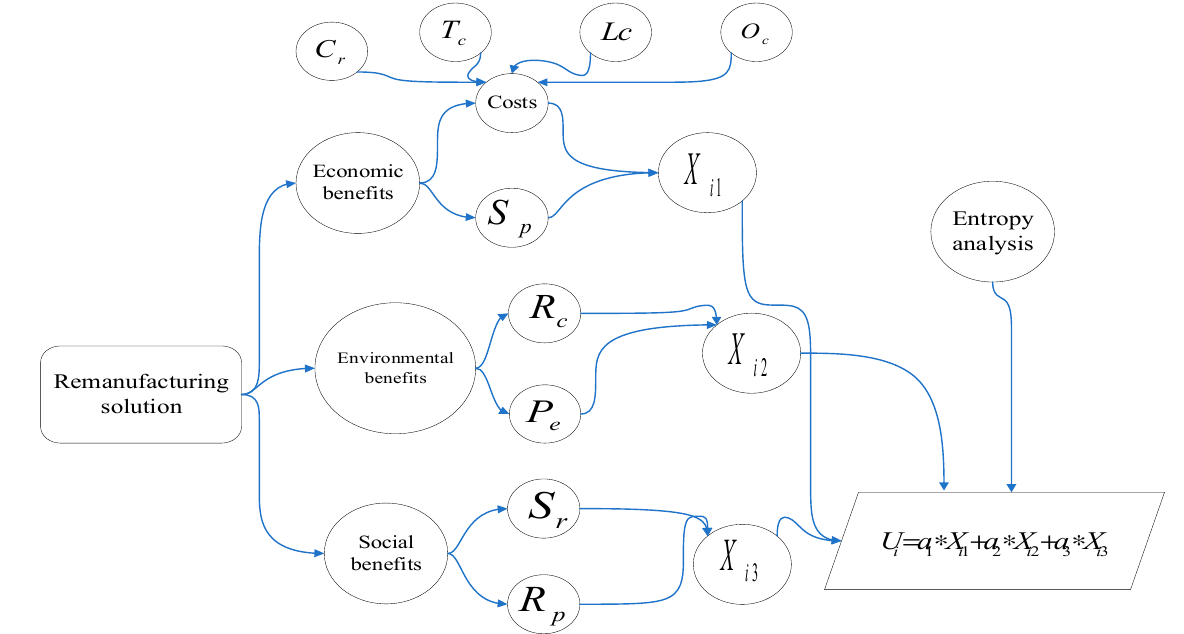
Figure 2. Remanufacturing strategy decision-making system.